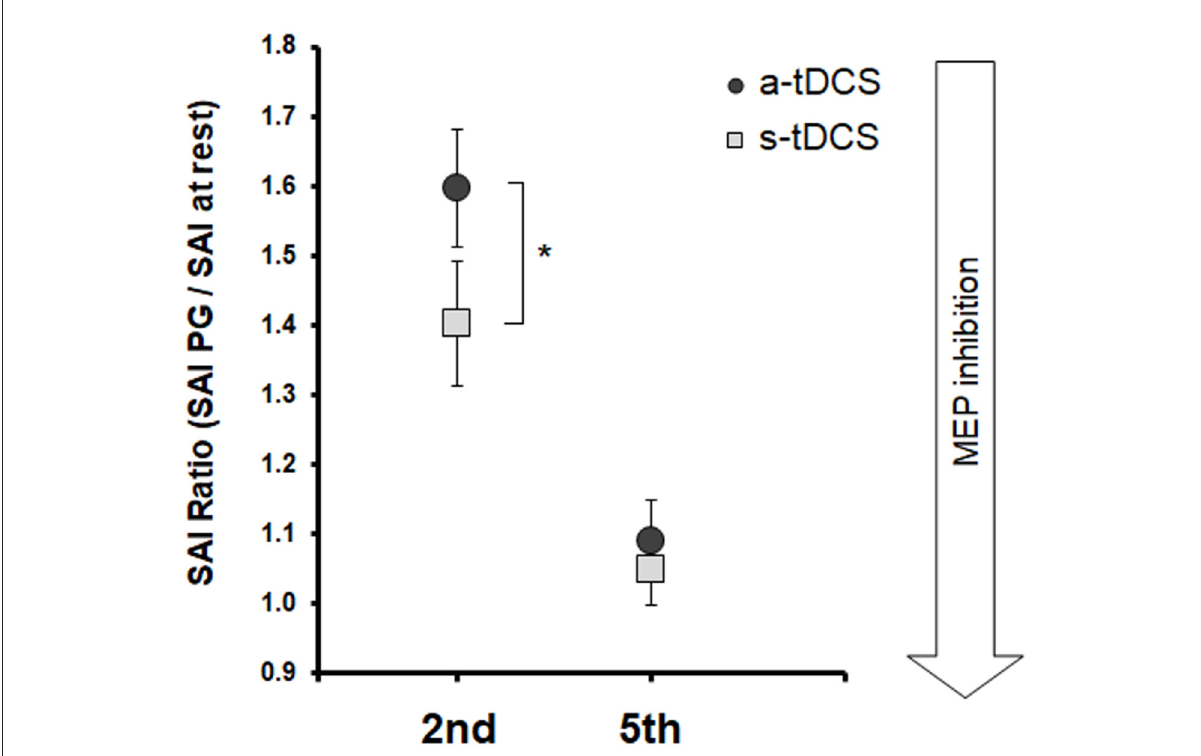
FIGURE3 Group averaged data (with standard error of the mean) of SAI Ratio, tested from FDI before 2nd and 5th fingers movement imagination, collected after a-tDCS (dark gray circles), or s-tDCS (light gray squares). Vertical bars indicate SE; asterisks indicate the level of significance (* refers to p < 0.05, ** refers to p <